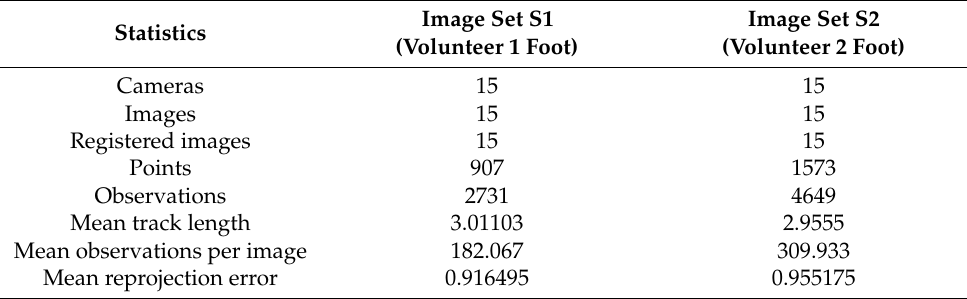
Table 8. Statistics data retrieved by COLMAP.